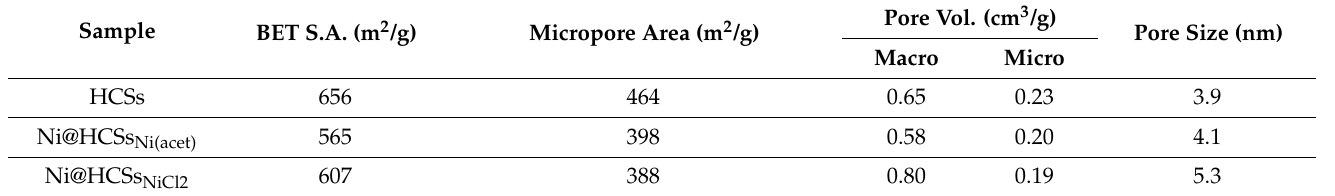
Table 1. Textual properties of pristine and Ni@HCSs samples.